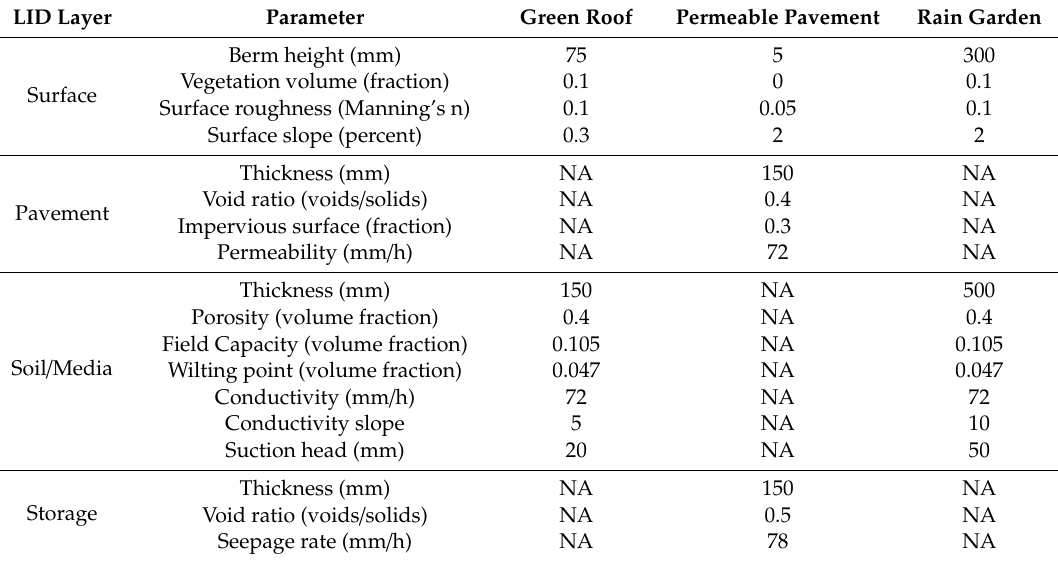
Table 4. Low Impact Development (LID) SWMM parameters